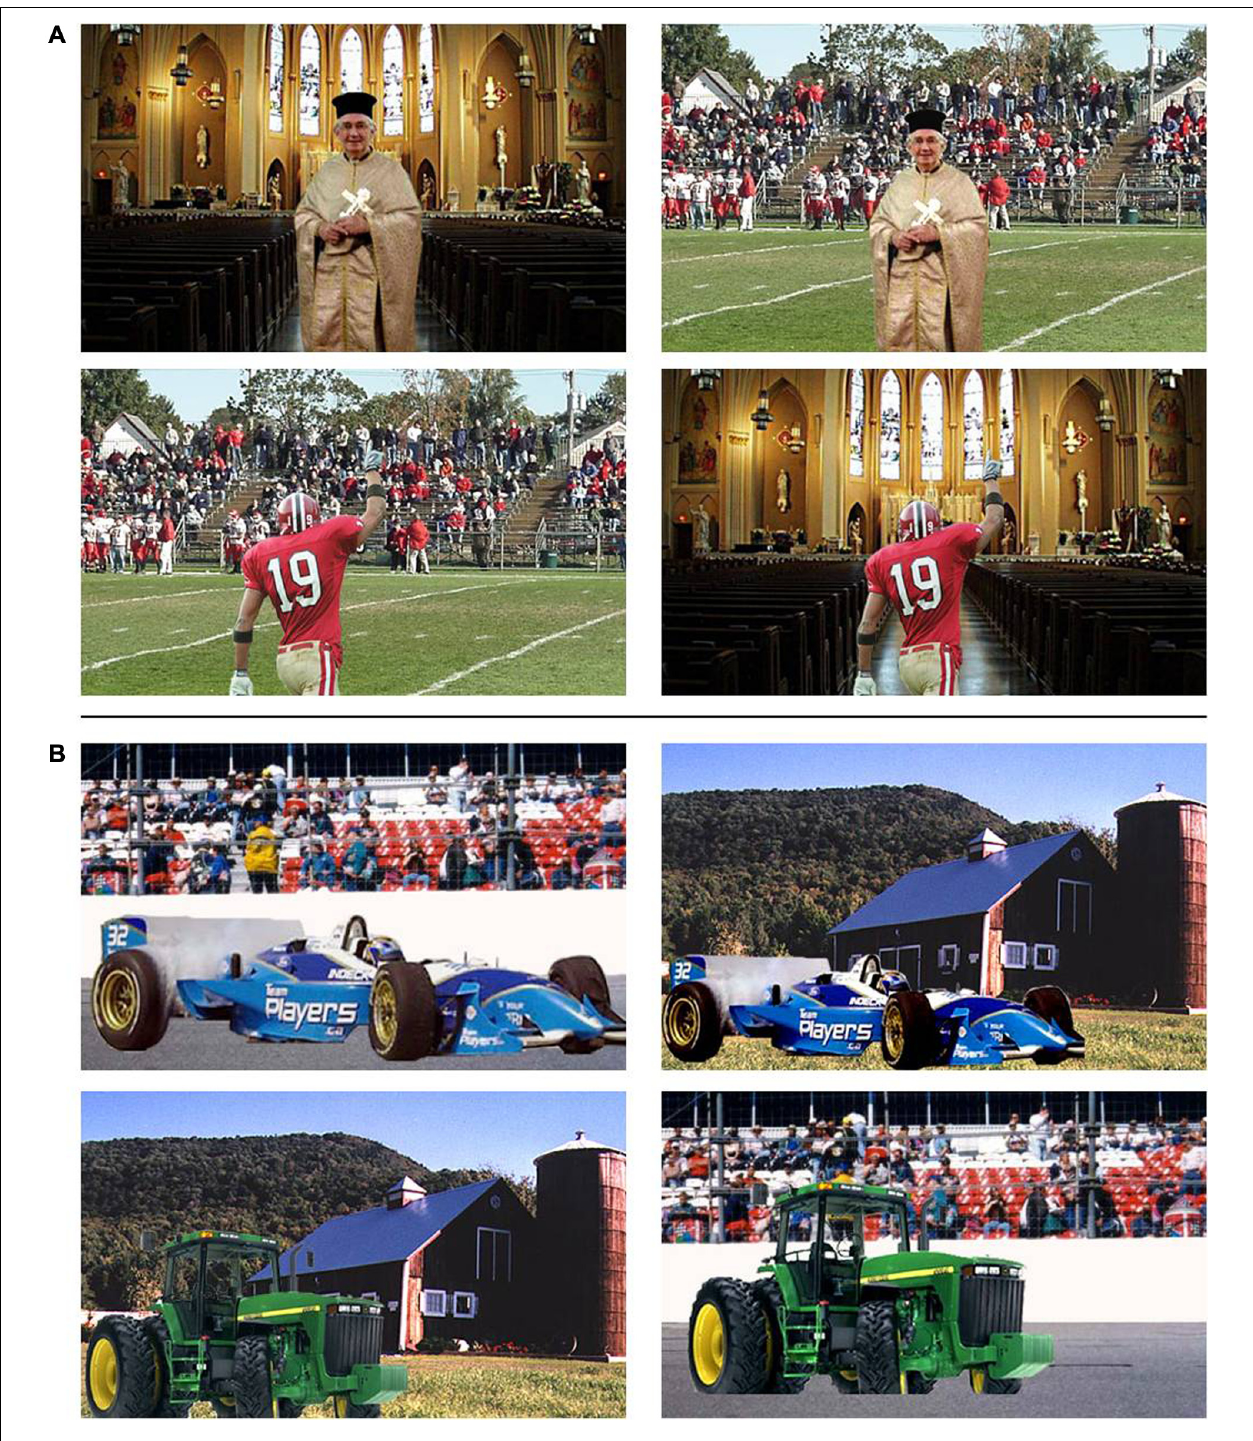
FIGURE 1 | Example stimuli from the original Davenport and Potter (2004) study and Experiment 1. Each object is presented in a consistent (left column) and inconsistent (right column) setting. (A) Example stimuli showing more overlap in low-level visual features between target object and background scene in the consistent scenes. For example, when presented on a semantically consistent background the color of the priest’s robes matches the color of the church wall and its ornaments. Similarly, the red-white